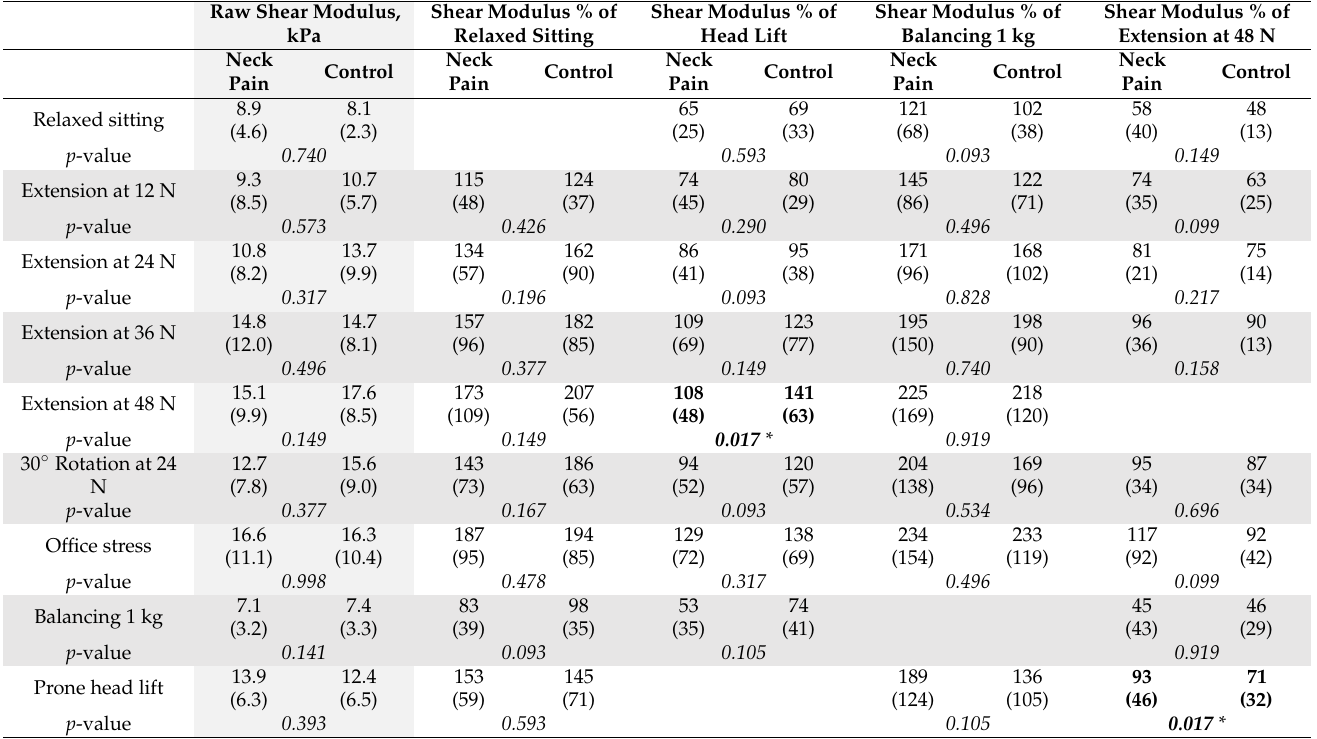
Table A1. Raw and normalized neck muscle shear modulus (median (interquartile range (IQR))) per task; p -value of the Mann–Whitney test for the between-group difference (in italics). * significant at p < 0.05 (in